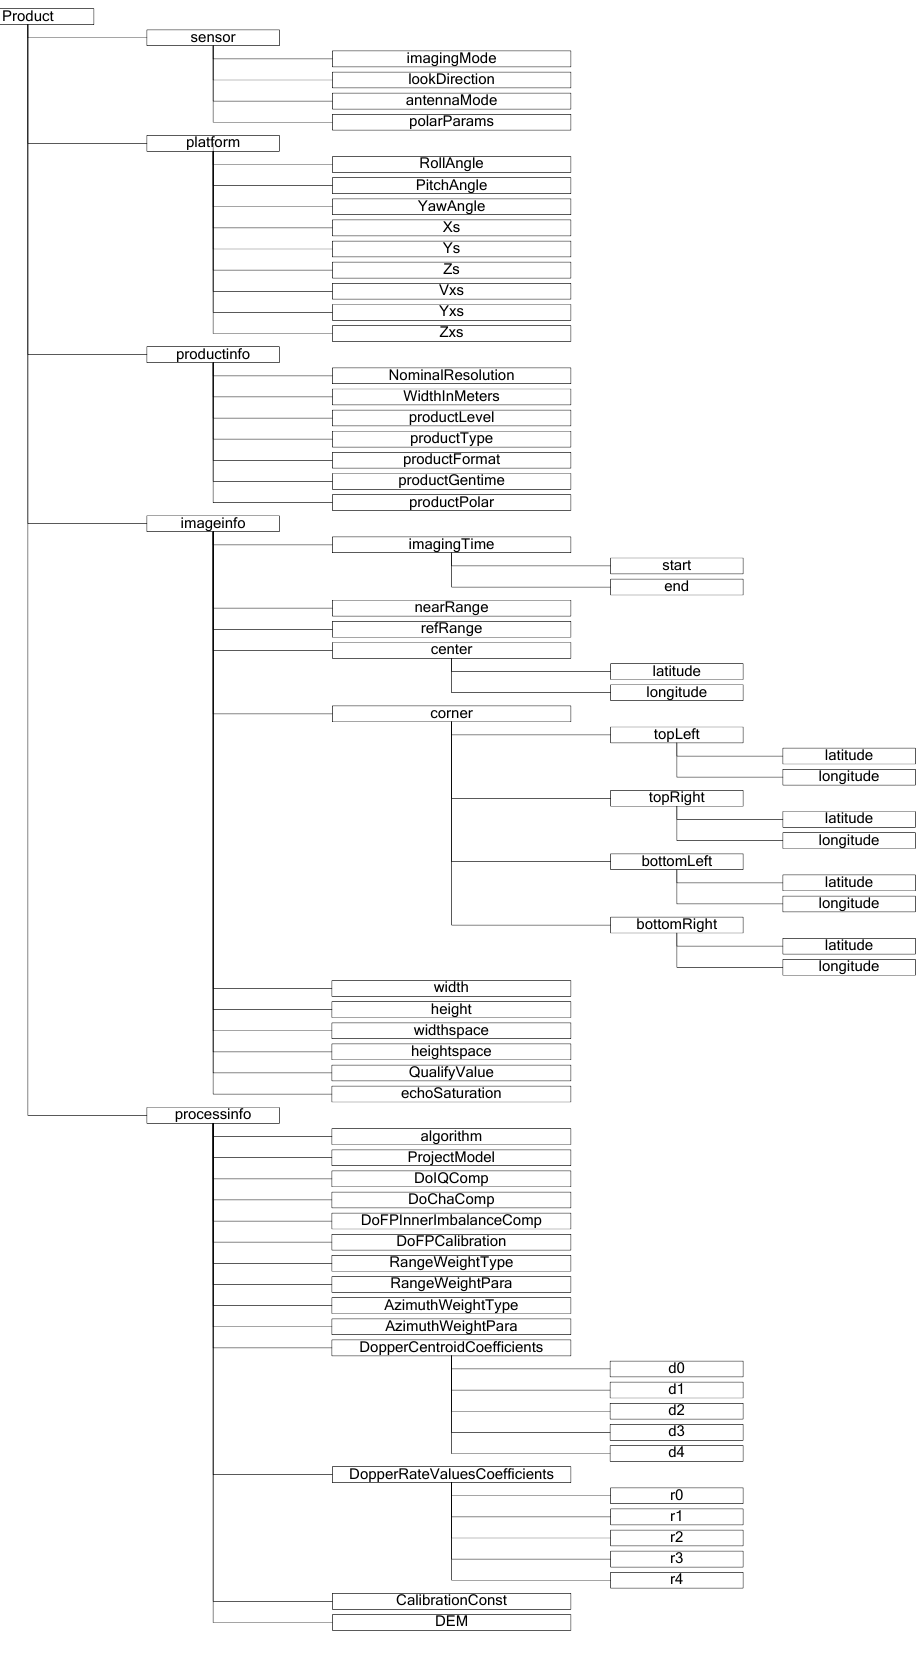
Figure A1. An overview of the XML meta-data structure for GF-3 products.